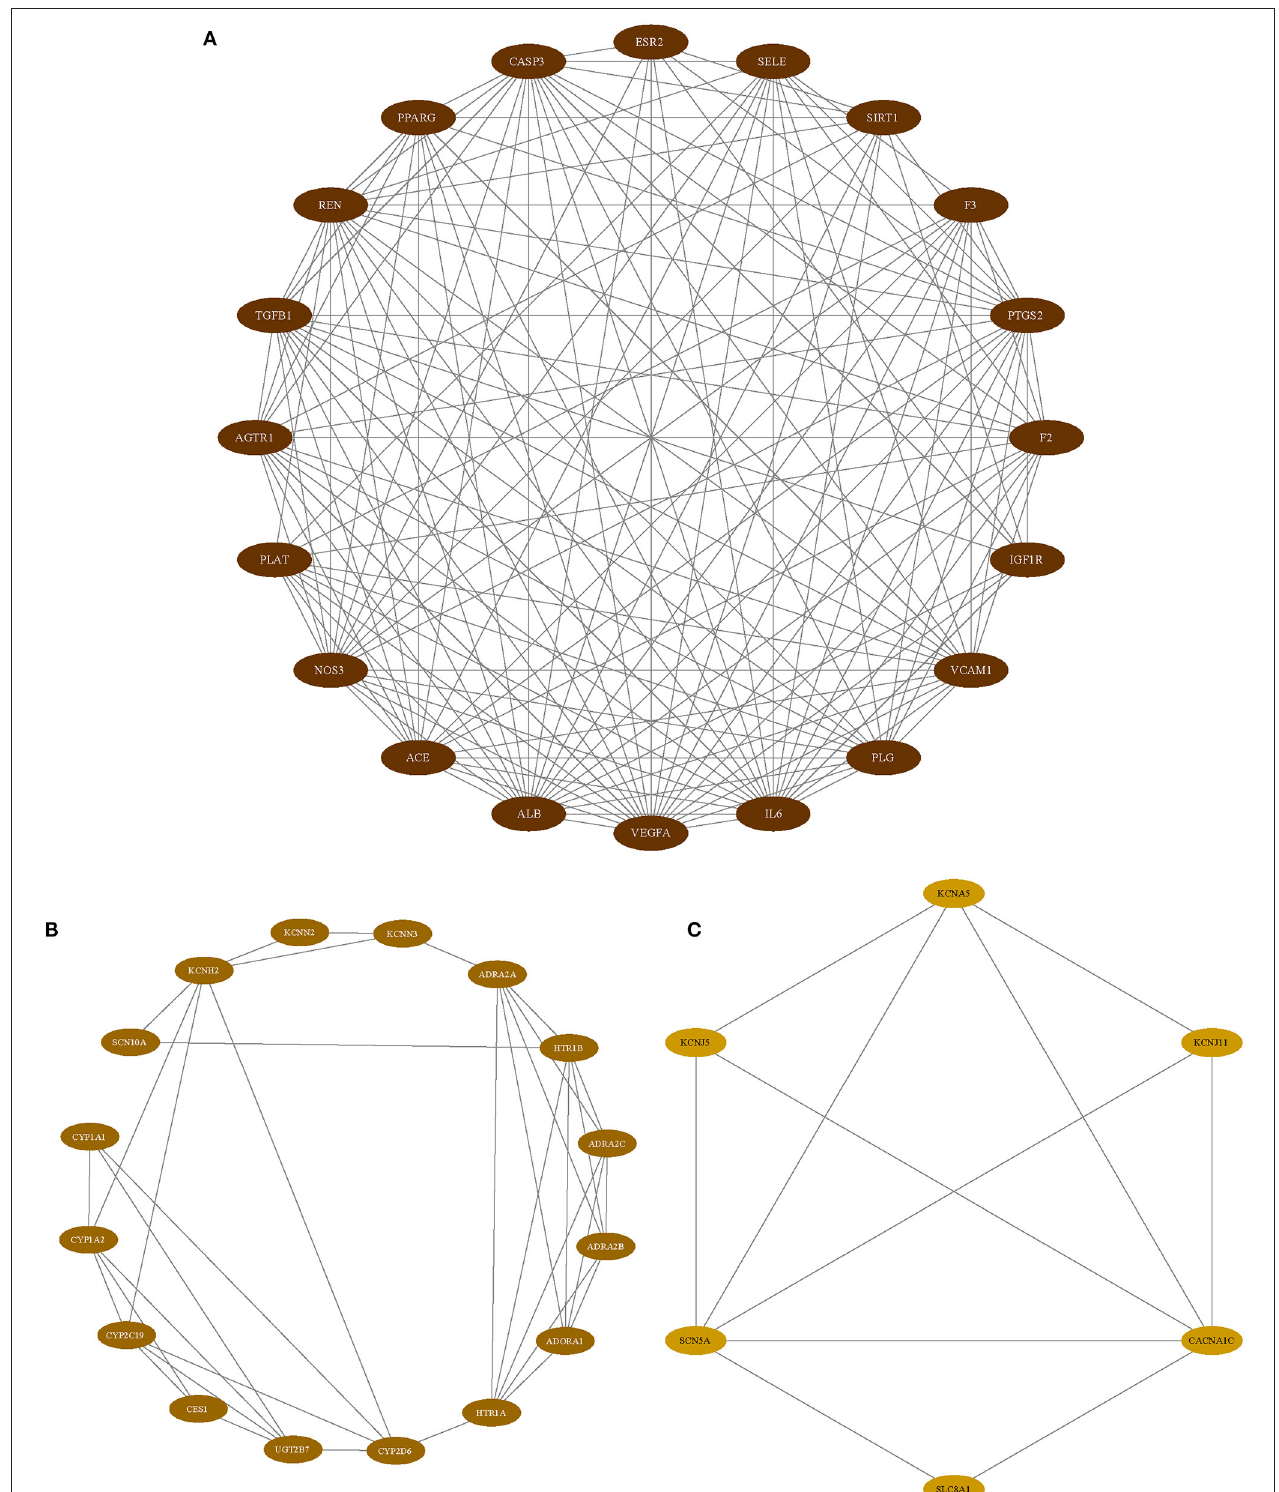
FIGURE 4 | The functional protein complexes. (A) Complex A. (B) Complex B. (C) Complex C.